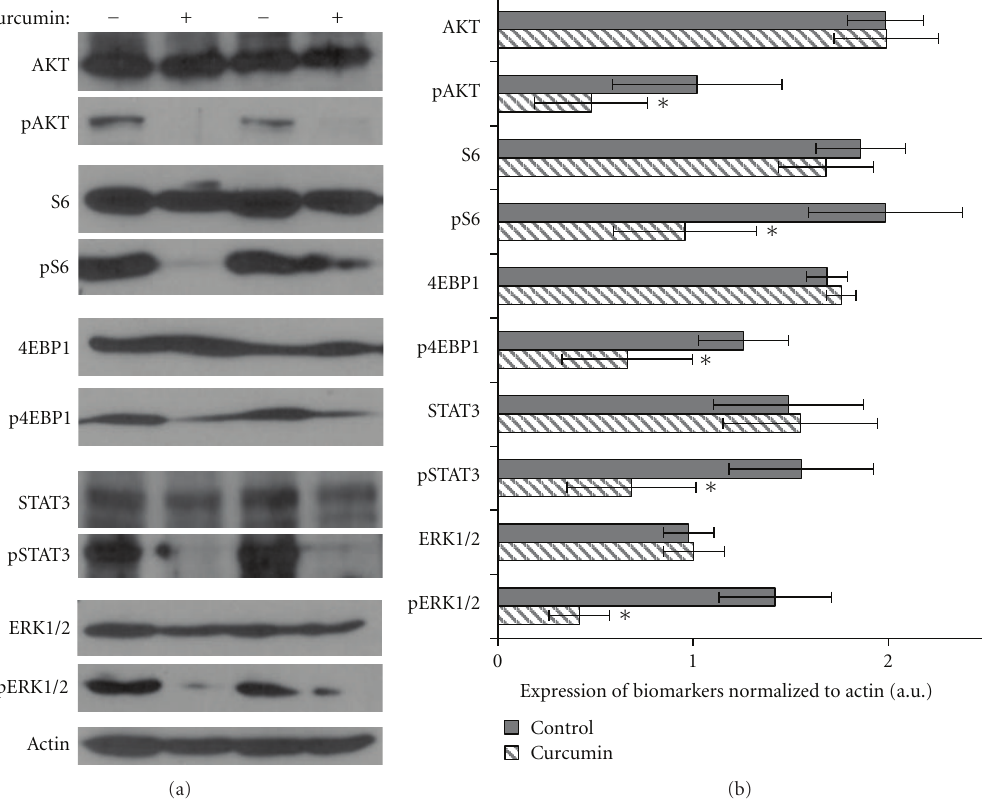
Figure 2: Curcumin’s e ff ects on AKT/MTOR and ERK pathways in vitro . (a) Western blot of SRB12-p9 tumor cells treated with (+) or without ( − ) 20 μ M curcumin for 24 hours and probed with the indicated antibody. Representative Western blots for two analyzed sets are shown. (b) Band densities of indicated biomarkers ( n = 6) were quantified using ImageQuant software and normalized to actin protein level. Data presented as Mean ± SE. ∗ Indicates P < 0 . 05 versus vehicle-treated control. A significant inhibition of expression of the following biomarkers was observed: pAKT ( P = 0 . 0368); pS6 ( P = 0 . 0182); p4EBP1 ( P = 0 . 0098); pSTAT3 ( P < 0 . 0001); pERK1/2 ( P = 0 . 0313). a.u.: arbitrary